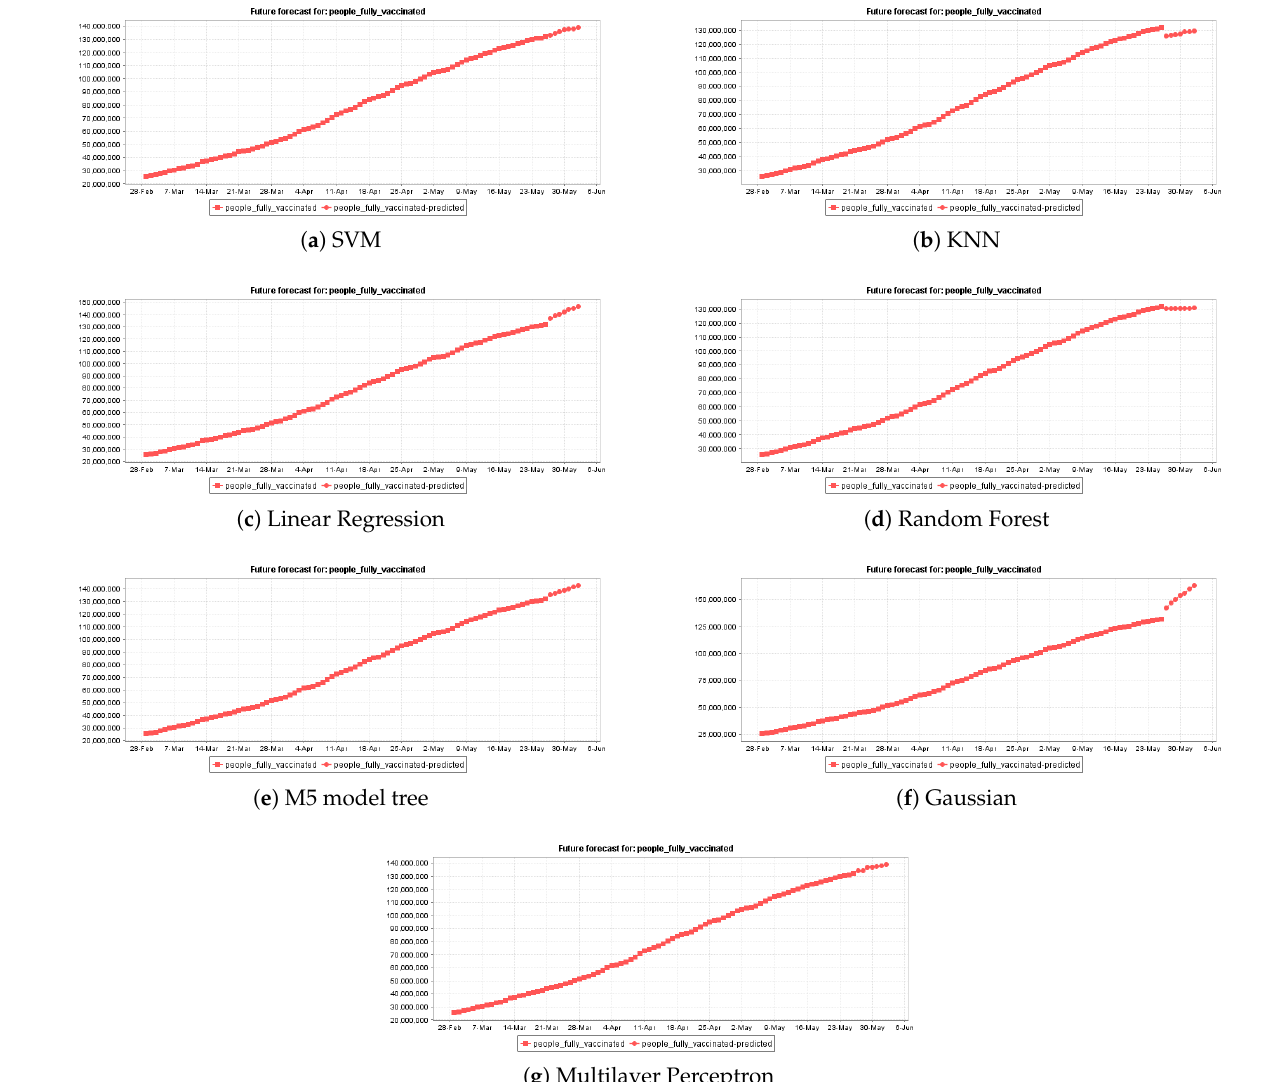
Figure A7. COVID-19 vaccination prediction for different machine learning models with forecast time of 1